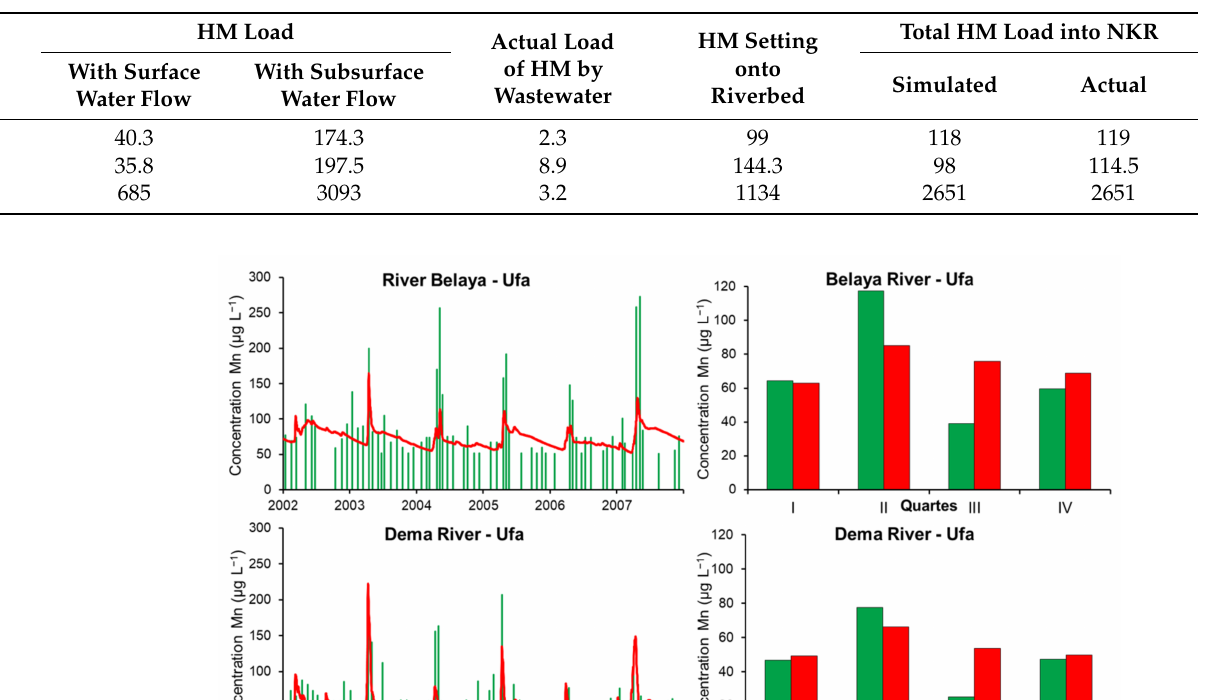
Table 3. Simulated components of HM load into the river network from the NKR watershed and the actual and simulated HM load into the NKR (t · year − 1 ).